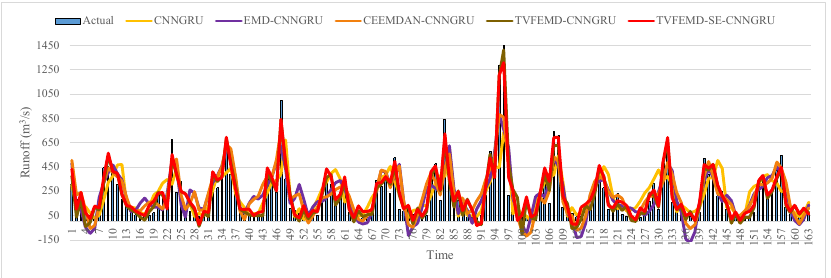
Figure 8. Forecasting curves estimated by a novel deep sequential structure incorporating CNN into GRU (CNNGRU) and all the decomposition-based models.